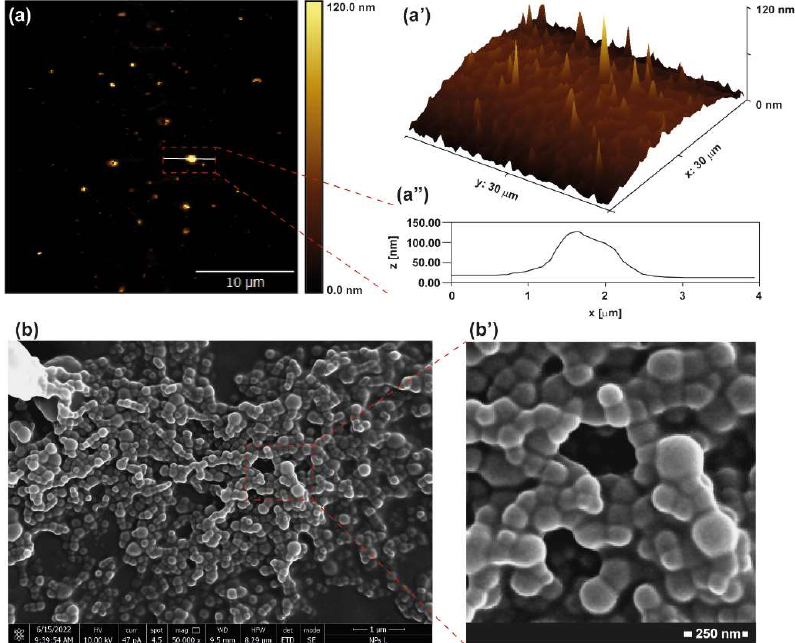
Figure 5. AFM images ( a–a’ ): 3D AFM micrograph and heights’ profile of particles ( a’’ ) were obtained from the rough data by Gwydion software. SEM images ( b–b’ ).